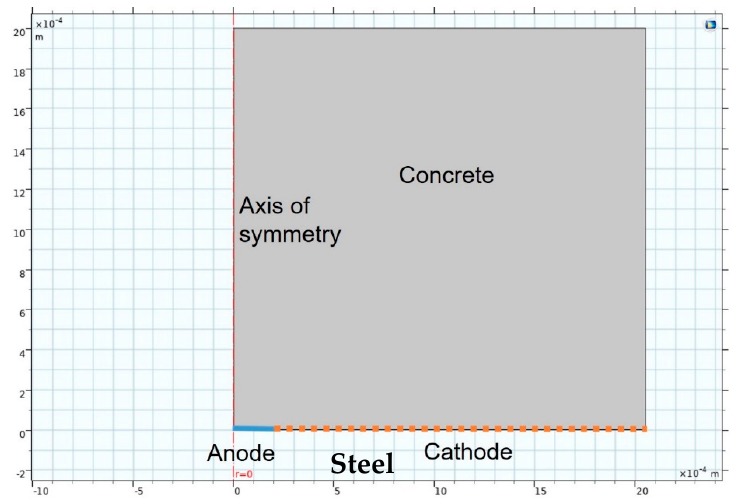
Figure 1. Finite elements model (FEM) simulation geometry.